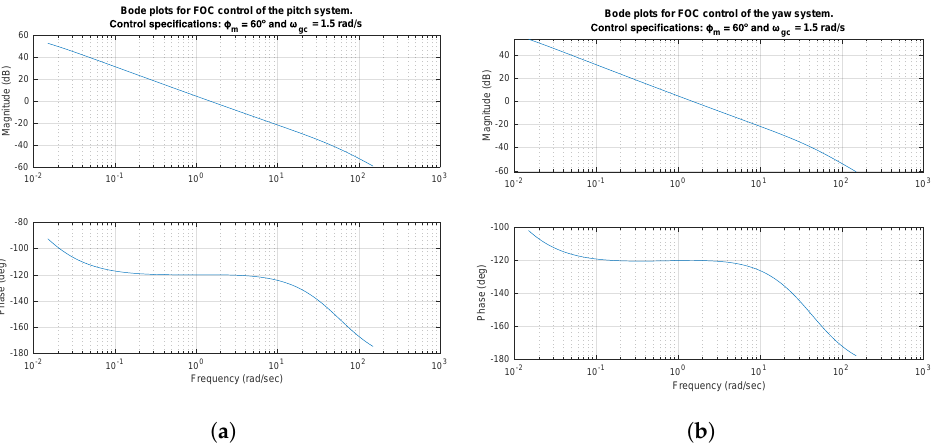
Bode plots for FOC control of the pitch system. m gc = 1.5 rad/s